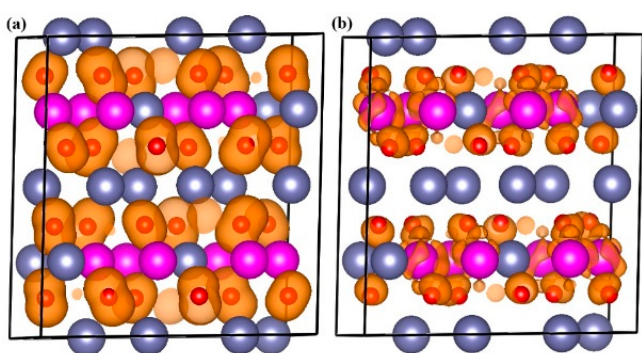
Figure 10. Iso-surfaces of charge density with given energy window of 0.2 eV from the bottom and top of the band edge ( a ) VBM (iso-surface value 0.008) and ( b ) CBM (iso-surface value 0.00001).